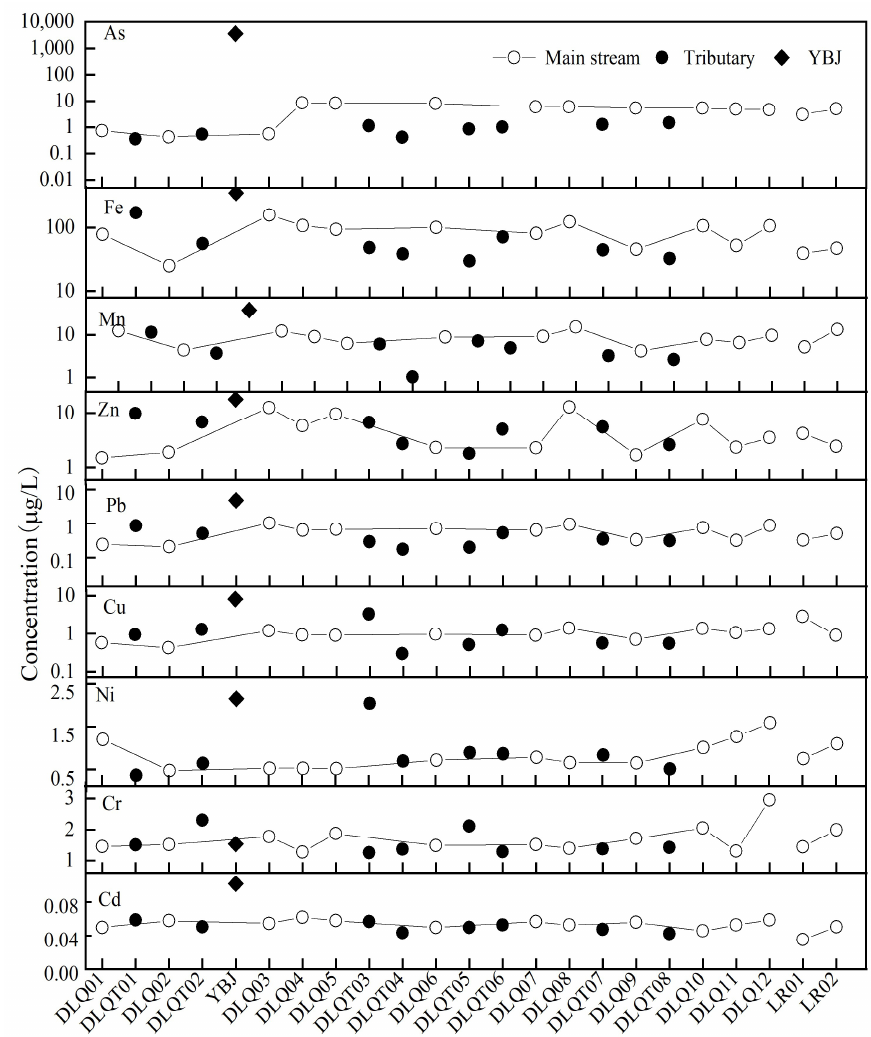
Figure 4. Spatial variations in heavy metals along the flow direction in DLQ.